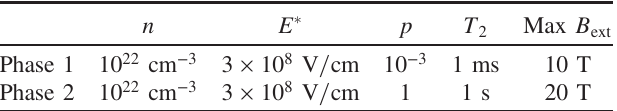
TABLE I. Parameters for phase 1 and phase 2 regions in Fig.